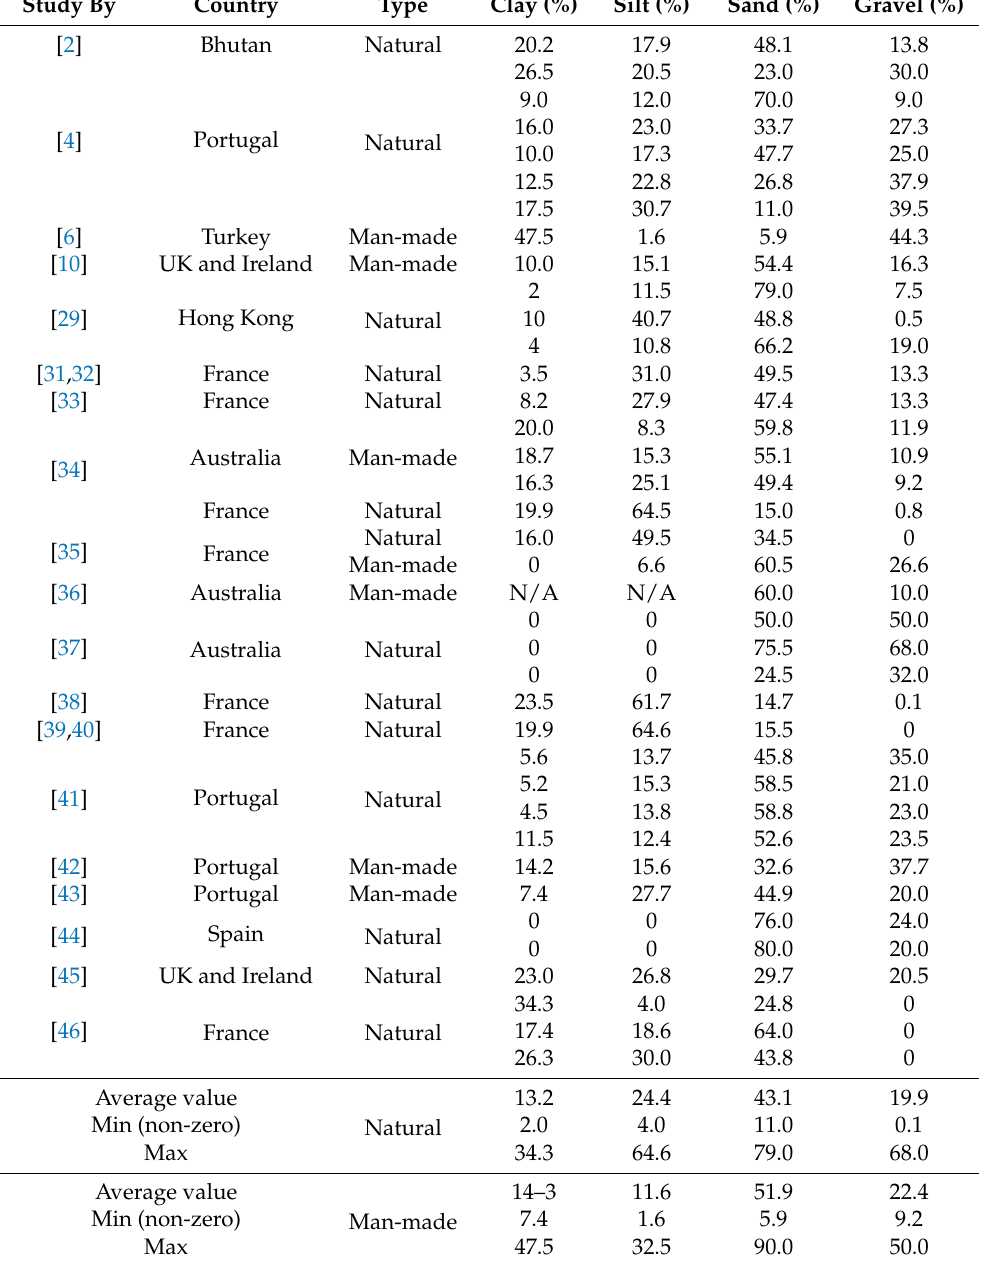
Table 1. PSD for RE-suitable soils and soil